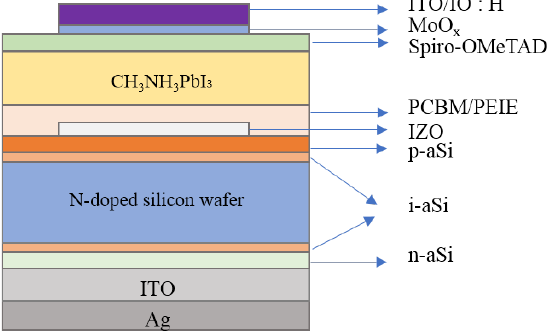
Figure 14: Monolithic perovskite / silicon tandem cell structure